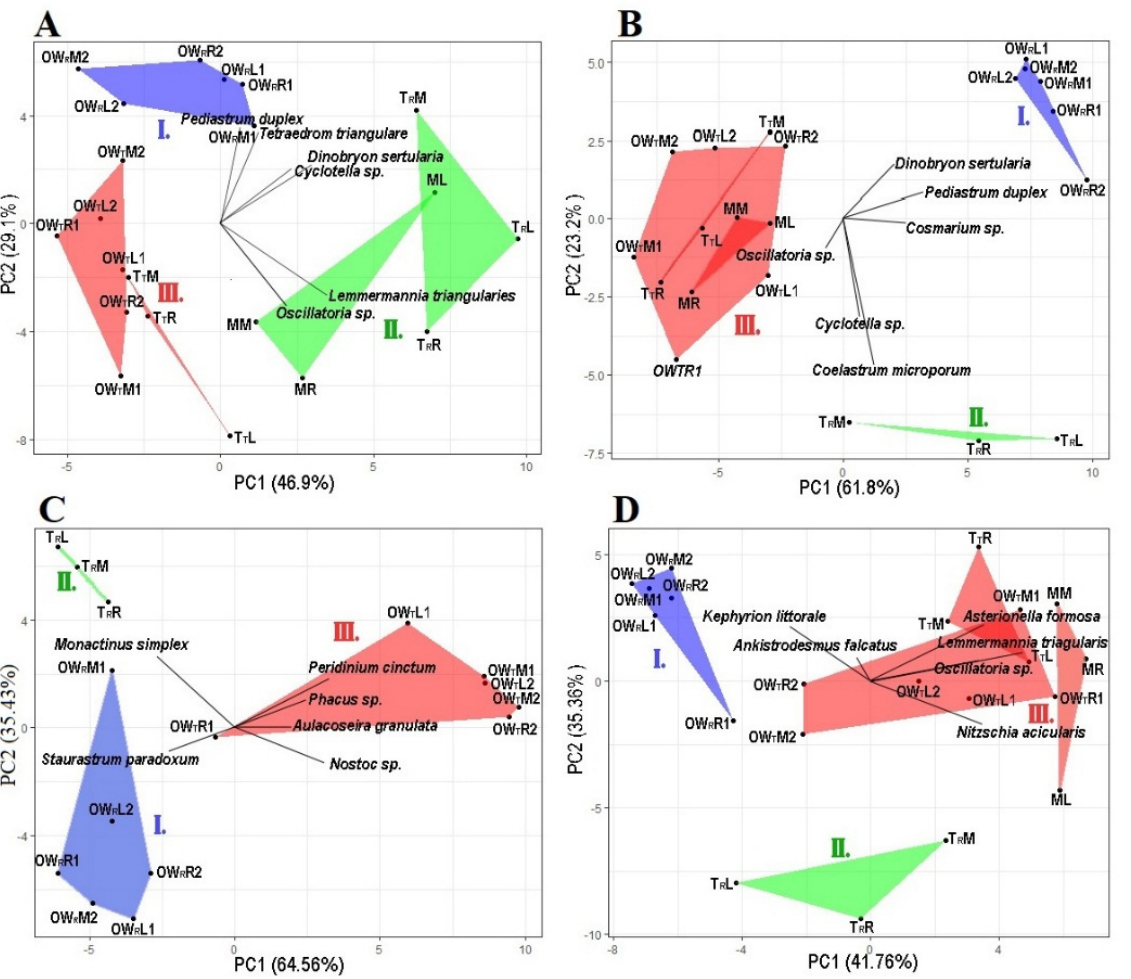
Figure 3. Principal component analysis of the algal plankton data at each sampling point. Graph ( A ): April, Graph ( B ): June, Graph ( C ): July, Graph ( D ): October. The groups are represented by the following colors: Group I is blue, Group II is green and Group III is red. OW R represents the open water zone of the Rakamaz area with the sampling transects and the sampling points. T R represents the transitional zone between the open water zone of Rakamaz area (OW R ) and the middle zone (M) which is characterized by a large macrovegetation coverage. T T represents the Transitional zone between the open water zone of Tiszanagyfalu area (OW T ) and the middle zone (M). OW T represents the open water zone of the Tiszanagyfalu area. The numbers 1 and 2 represent the transects inside the zones. The letter L represents the left parts of the transects, M represents the middle parts of the transects, and R represents the right parts of the transects; these abbreviations apply to all sampling points.